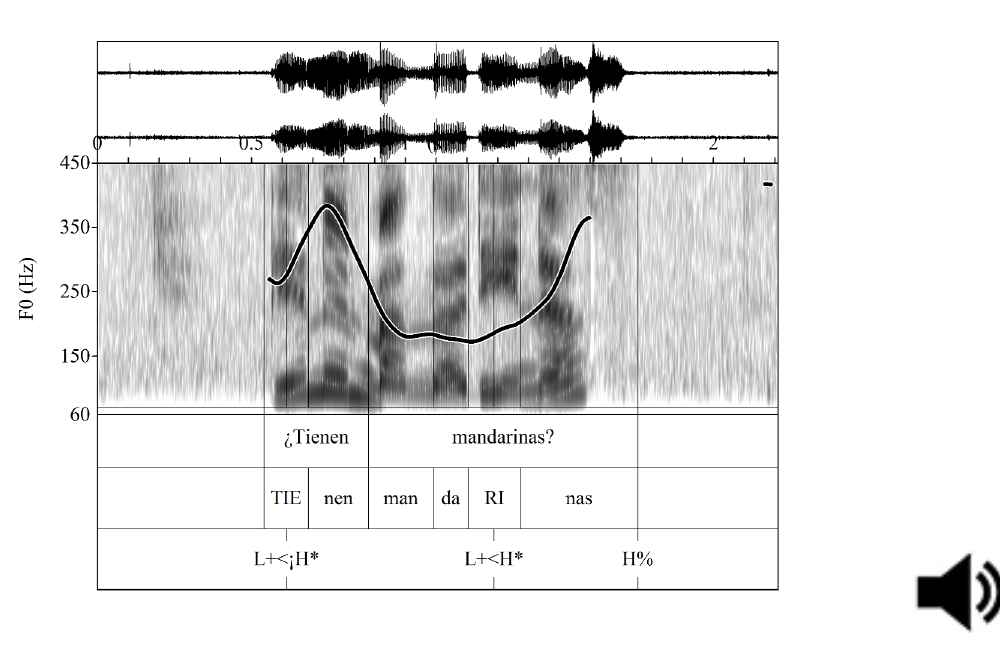
Figure 6 (Participant 9): Waveform and F0 trace for the info seeking yes-no question ¿ Tienen mandarinas? ‘Do you have tan- gerines?’ produced with L+<H* in both pre-nuclear and nuclear positions followed by an H% boundary